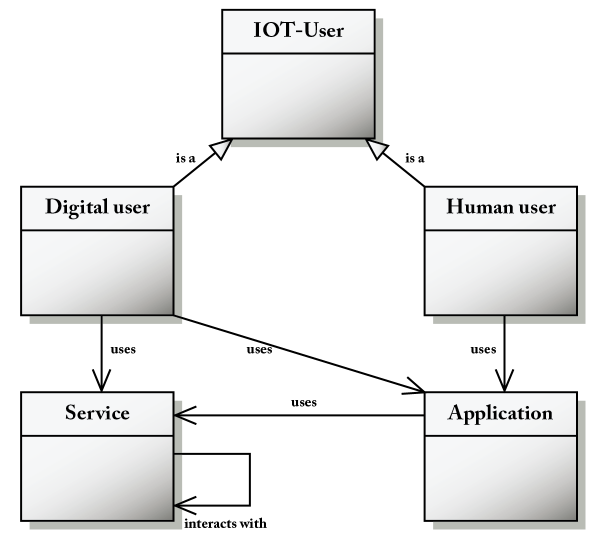
Figure 3. The IoT user class